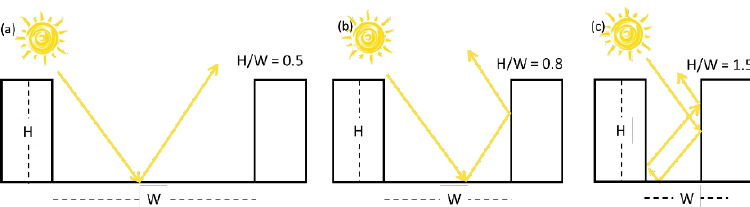
Figure 3. Three levels of the H/W ratio: ( a ) H/W equal to 0.5 (no urban canyon); ( b ) H/W equal to 0.8 (urban canyon condition); ( c ) H/W equal to 1.5 (typical of densely built